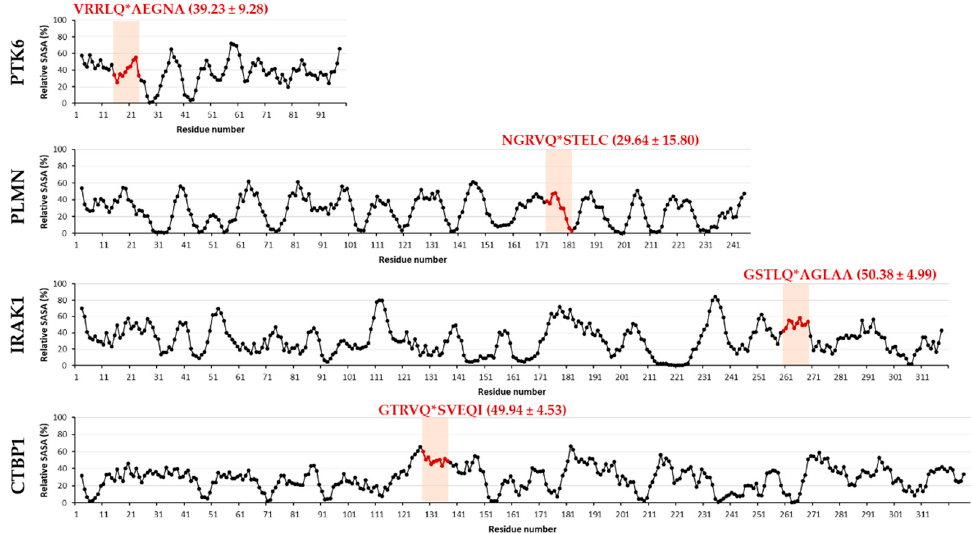
Figure 7. Analysis of surface-accessible surface areas. Relative surface-accessible surface area (SASA) values (%) determined for all atoms in PTK6, PLMN, IRAK1, and CTBP1, and were averaged for every position in a 5-residue window. Values for P5–P5’ residues are highlighted by red, the average-of-average and SD values calculated for P5–P5’ sites are shown in brackets. Residue numbering starts in each case from the first residue of the protein in the coordinate file.